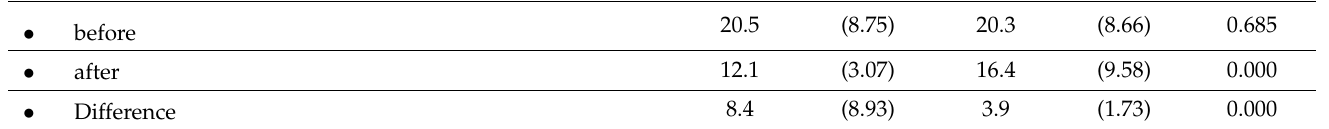
SCIT Group Control Group ( n = 1.098) ( n = 1.098)